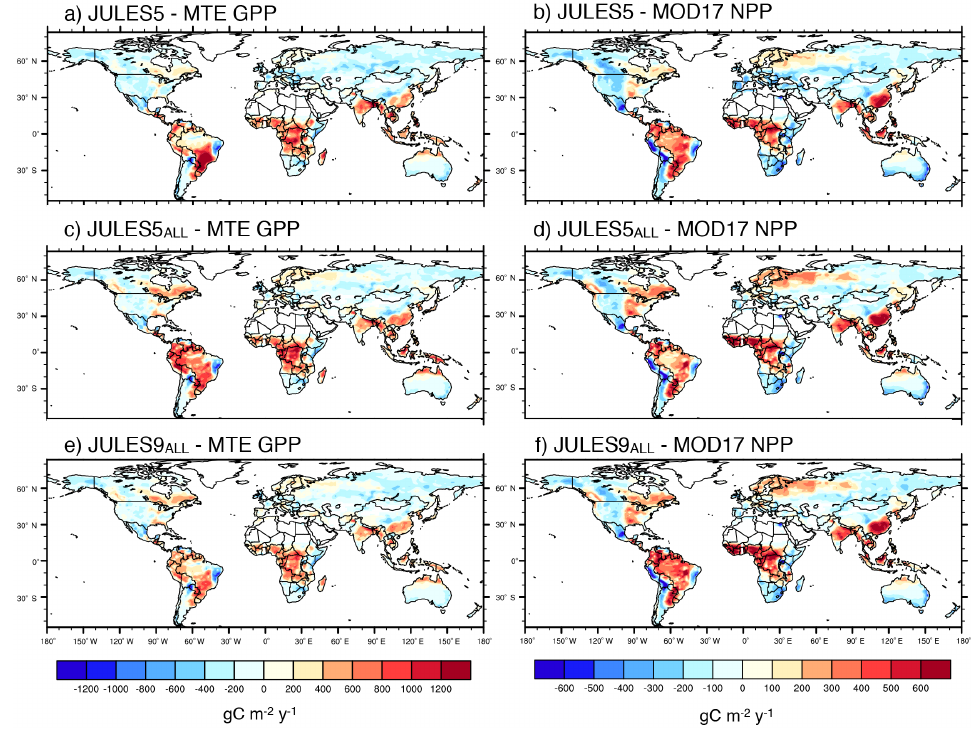
Figure 9. Differences between modeled and observed GPP (observed – MTE) and NPP (observed – MOD17). (a, b) JULES with the standard five PFTs and default parameters; (c, d) JULES with five PFTs and improved parameters; (e, f) JULES with nine PFTs and improved